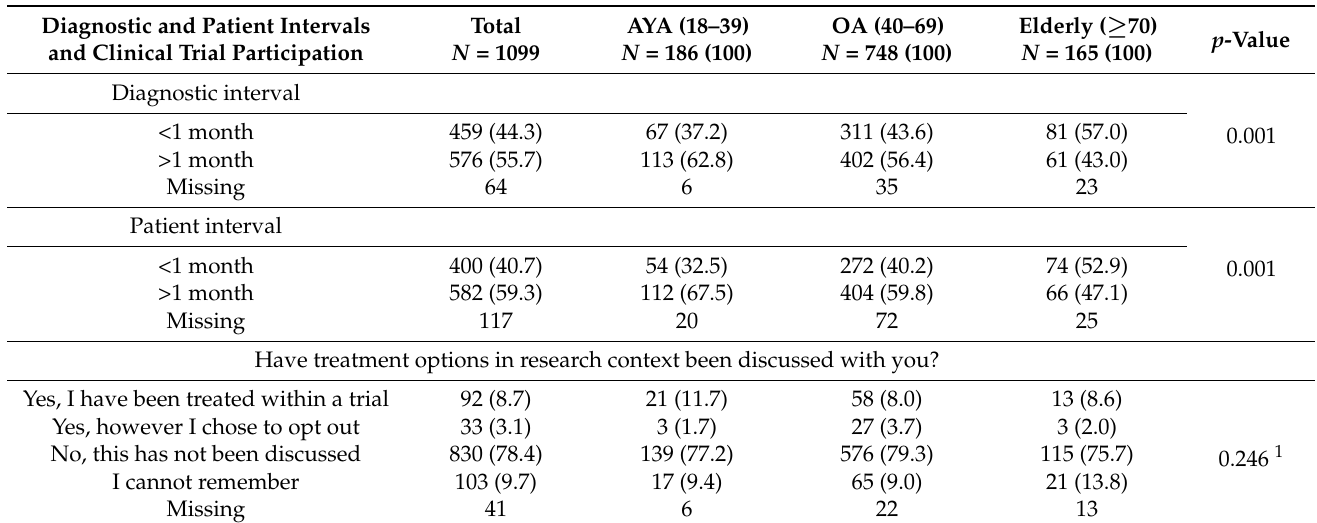
Table 4. Diagnostic and patient intervals and clinical trial participation in rare cancer patients.